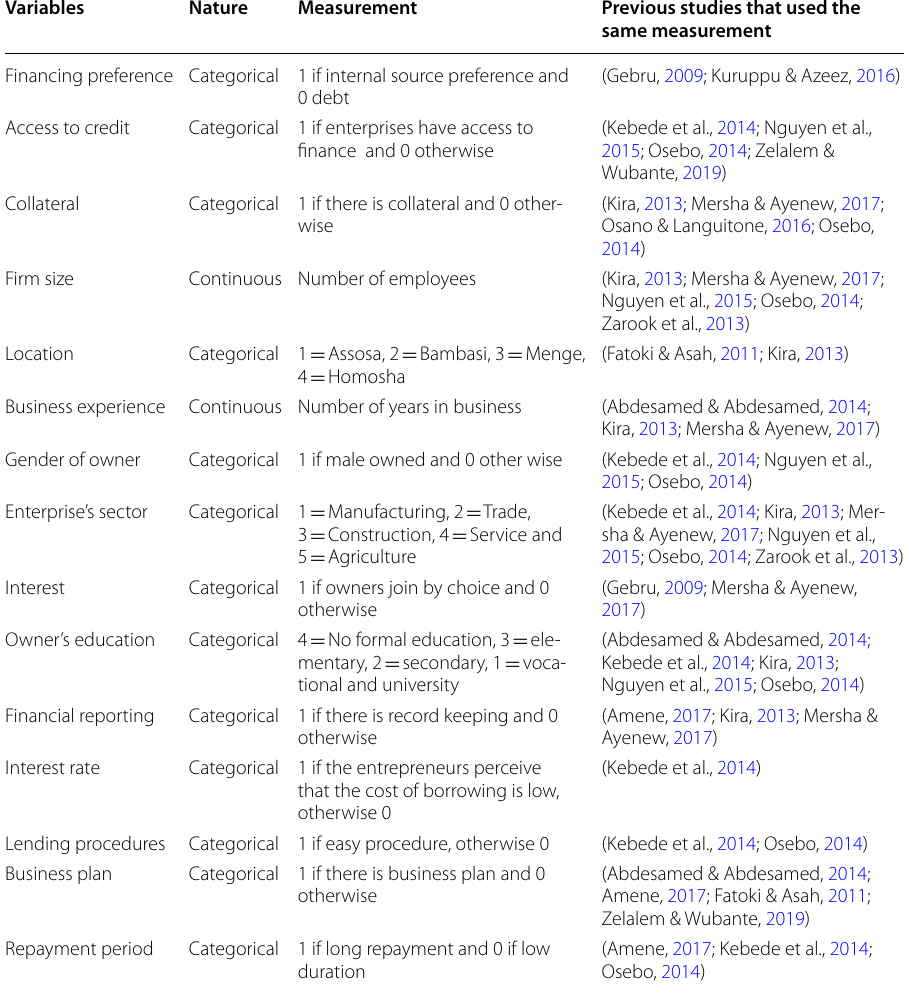
Table 3 Nature and measurement of variables Variables Nature Measurement Previous studies that used the